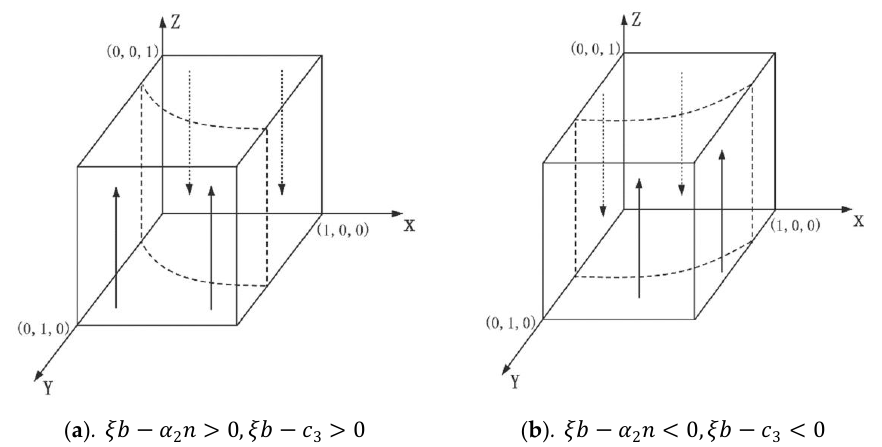
Figure 4. Evolution phase diagram of the public strategy selection under different